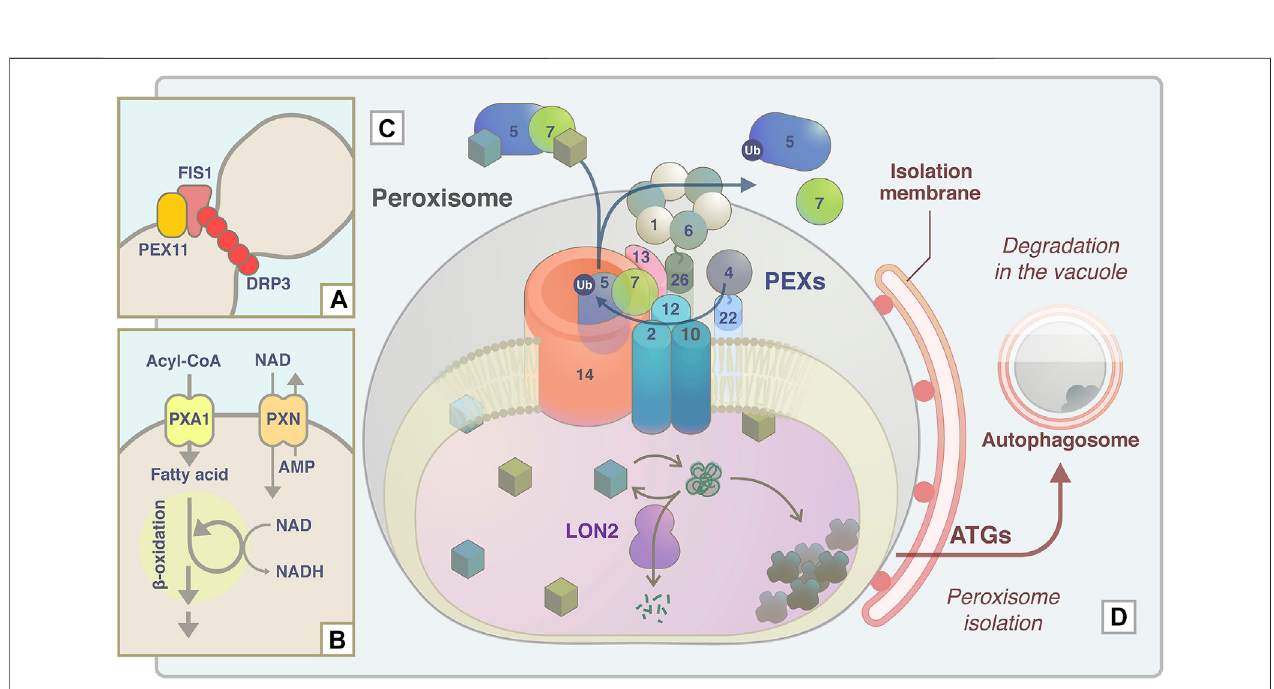
FIGURE 4 | Schematic model of APEM protein functions in peroxisome proliferation, lipid metabolism, protein transport machinery, and quality control. (A) During peroxisome fi ssion, DRP3A/APEM1 is recruited to the peroxisome division site together with DRP3B in a PEX11- and FIS1-dependent manner (Kao et al., 2018). DRP proteins are polymerized and constrict to divide peroxisomes. (B) PXN/APEM3 import NAD into the peroxisomal matrix and this is required for optimal fatty acid β - oxidation. (C) Peroxisomalmatrixproteinsarecapturedbythereceptor PEX5orPEX7.ThePEX5-PEX7-cargo complextranslocatestoperoxisomesbybindingto the docking complex consisting of PEX14 and PEX13/APEM2. The E2 ubiquitin ligase PEX4 and the E3 ligase PEX2/PEX10/PEX12 supposedly ubiquitinate PEX5 to export it from the peroxisomal membrane with/without the force generated by the APEM9/PEX15/PEX26-tethered AAA-ATPase PEX1-PEX6 complex. Experimental data support the interactions between PEX13 and PEX7 (Mano et al., 2006), PEX13 and PEX15/PEX26 (Li et al., 2014), and PEX7 and PEX12 (Singh et al., 2009). (D) Damaged and/or unwanted peroxisomal proteins are supposedly maintained or degraded by the chaperone/protease activity of LON2/APEM10 protein. Excess damagedproteinsaccumulateinsideperoxisomes. Peroxisomesbecomeoxidativeuponcatalaseinactivationand aggregation, andtheseperoxisomes aretargeted for pexophagy to be degraded in the vacuole (Shibata et al., 2013). ATG proteins, including ATG2/PEUP1, ATG18A/PEUP2, ATG7/PEUP4/PEUP22, and ATG5/PEUP17, are involved in this